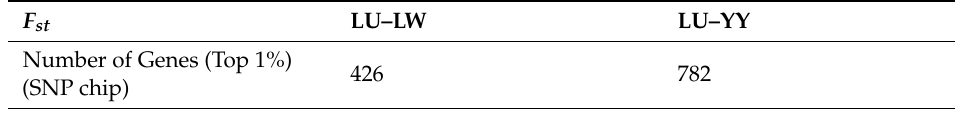
Table 1. Mapping results of significant genes of rIBD and F st